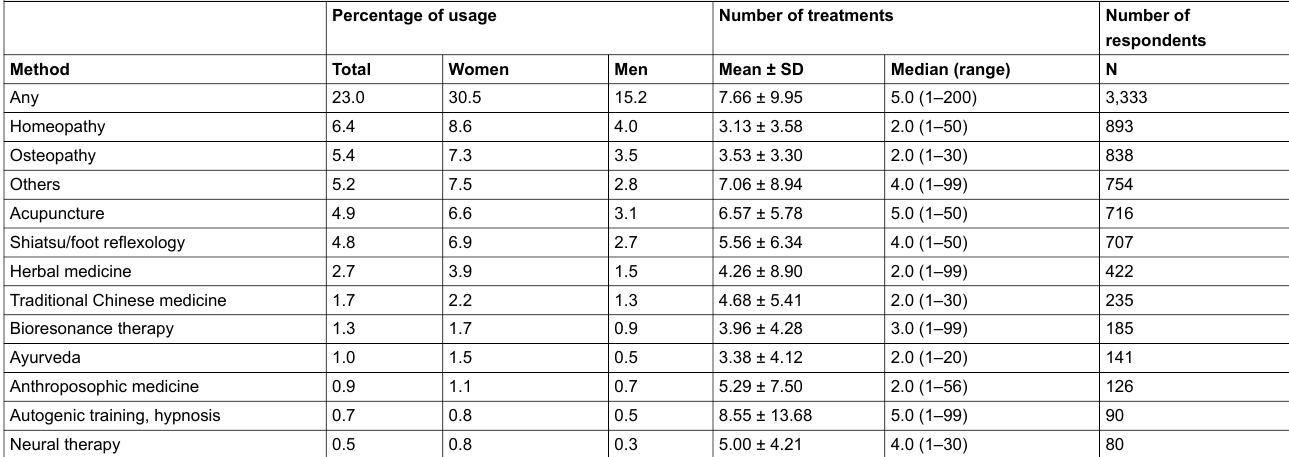
Table 2: Usage of various methods of CM in the last 12 months with respect to gender and average number of treatments (Swiss Health Survey, Switzerland,